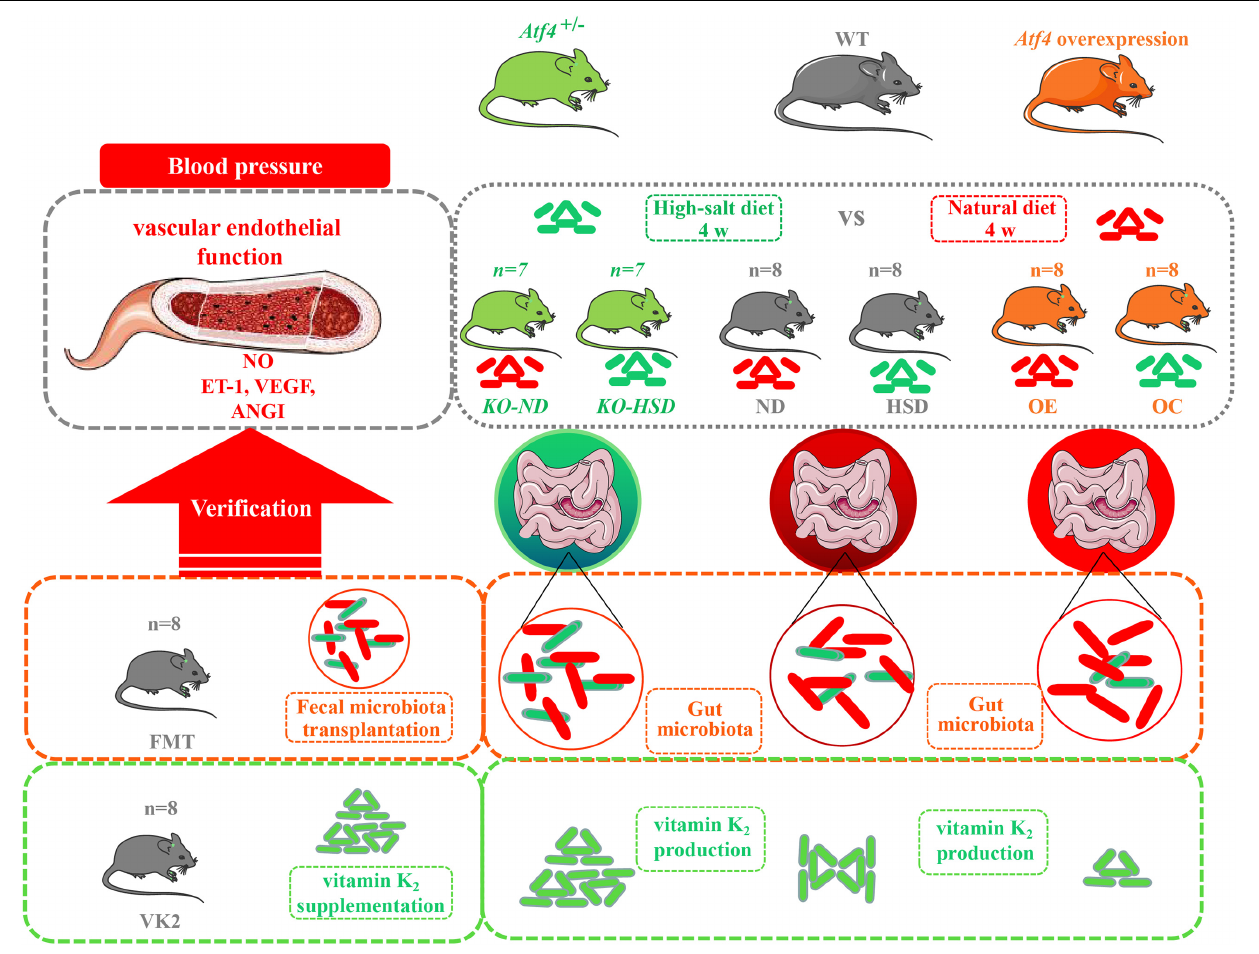
FIGURE 1 | The cartoon of experimental design to investigate the potential mechanism of ATF4 participating in high-salt diet-induced hypertension. Wild-type (WT) C57BL/6J mice, Atf4 knockout ( Atf4 ± ) and Atf4 overexpression mice were used and high-salt-diet (8% NaCl) for 4 weeks was used to induce hypertensive mice. Then, fecal microbiota transplantation from Atf4 ± mice and vitamin K 2 supplementation were separately carried out to verify the gut microbiota-related evidence of the association between ATF4 and blood pressure. ATF4, activating transcription factor 4; KO, Atf4 ± mice; WT, wild-type mice; NO, nitric oxide; VEGF, vascular endothelial growth factor; ANGI, angiotensin I; ET-1, endothelin-1; KO-ND, Atf4 ± mice with natural diet; KO-HSD, Atf4 ± mice with high-salt diet; ND, WT mice with natural diet; HSD, WT mice with high-salt diet; OE, Atf4 overexpression with high-salt diet; OC, Atf4 overexpression control with high-salt diet; FMT, fecal microbiota transplantation; VK2, vitamin